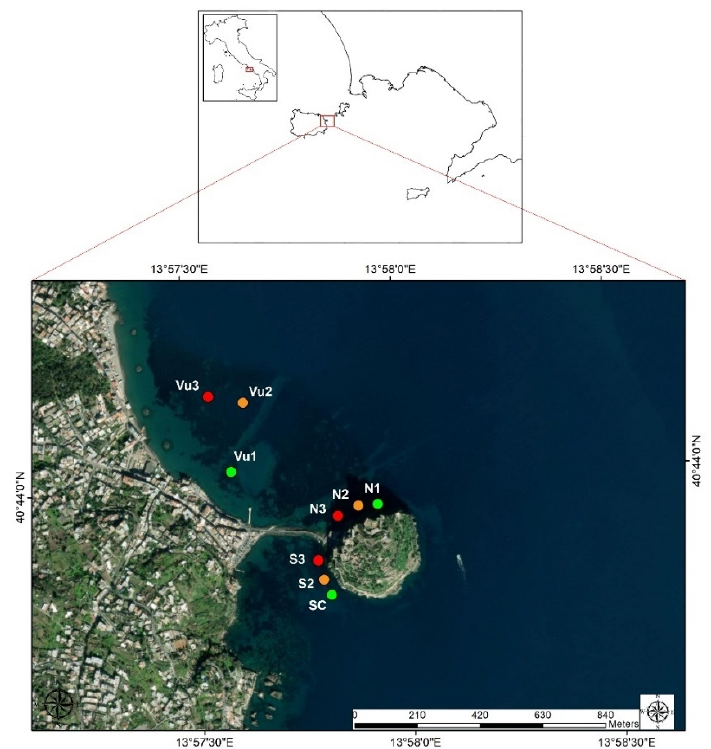
Figure 1. Location of the study area and disposition of the sampling stations along a pH gradient. Control/ambient conditions (Vu1, N1, and SC) are highlighted in green, low pH conditions (Vu2, N2, and S2) are indicated with orange, and extremely low pH conditions (Vu3, N3, and S3) are highlighted in red. Study sites were distinguished as follows: Vu-Vullatura; N-North of Castello Aragonese; S-South of Castello Aragonese. Basemap source: ESRI.